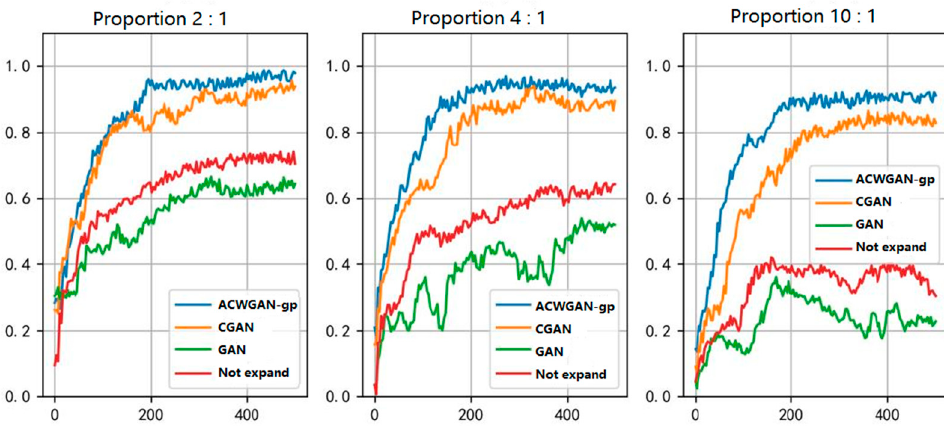
Figure 13. LSTM classification accuracy under different ratios of normal samples and fault samples.